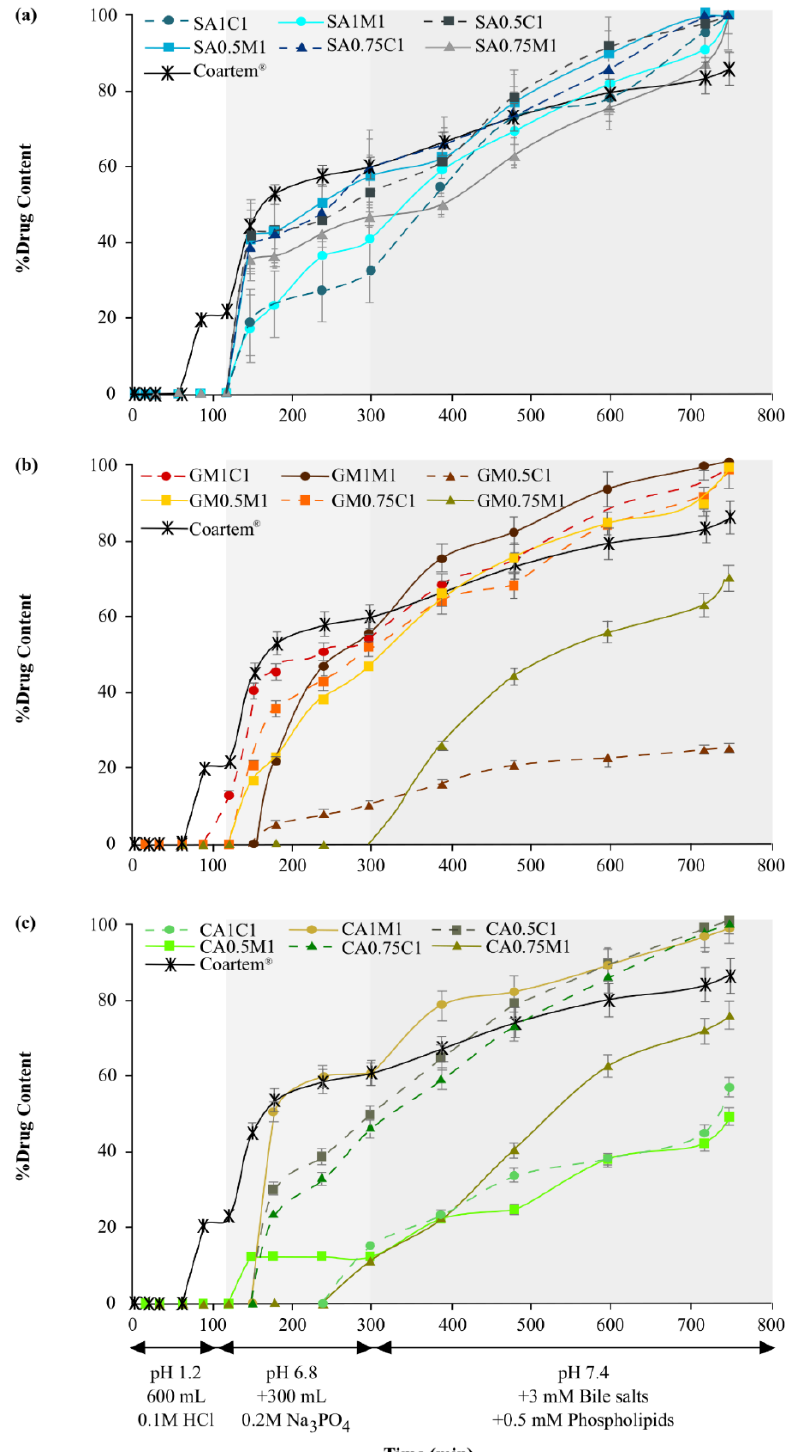
Figure 2. Effect of the inclusion of sequential dissolution media during dissolution behavior studies on the artemether release profiles for the respective ( a ) stearic acid, ( b ) glycerol monostearate and ( c ) cetyl alcohol formulations. The shaded areas and annotations denote the time-points for the changes in dissolution media ( n = 6).